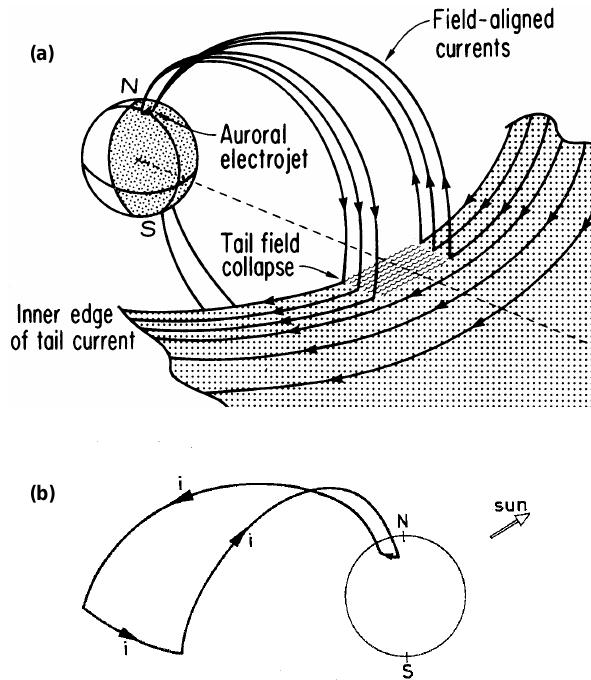
Fig. 1. (a) Three-dimensional real current system proposed by McPherron et al. (1973) to explain the observed magnetic field perturbation pattern at the earth’s surface during the development of the expansive phase of a magnetospheric substorm. In this framework, the expansive phase onset signals the short-circuiting of crosstail current through the auroral ionosphere (after McPher- ron et al., 1973). (b) Three dimensional equivalent current system used by Bonnevier et al. (1970) to represent the magnetic perturba- tion pattern associated with the EP of magnetospheric substorms. In this representation, dawnward equivalent current flow in the mag- netic equatorial plane could be considered to represent a decrease in duskward real current flow. In a similar vein, downward equiv- alent current flow could be considered to represent a decrease in pre-existing real upward current flow (after Bonnevier et al.,